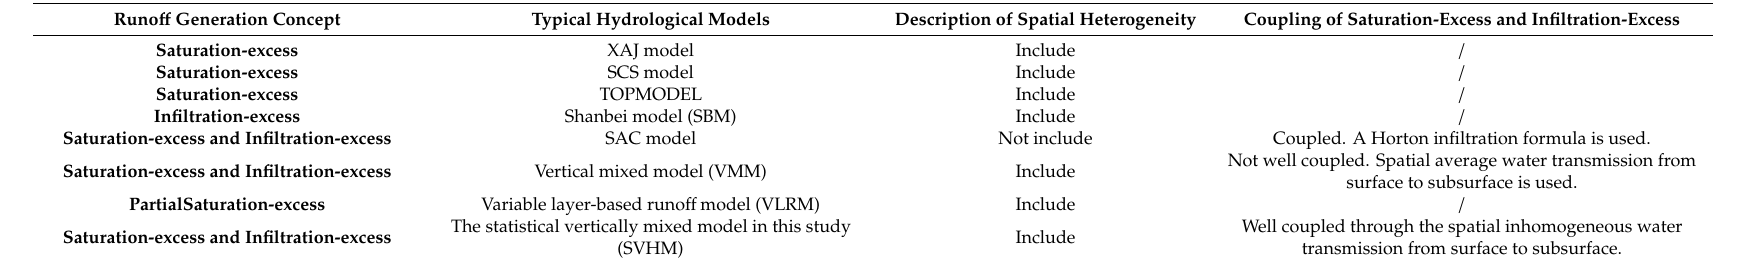
Table 4. Comparisons in runo ff concept of some typical hydrological